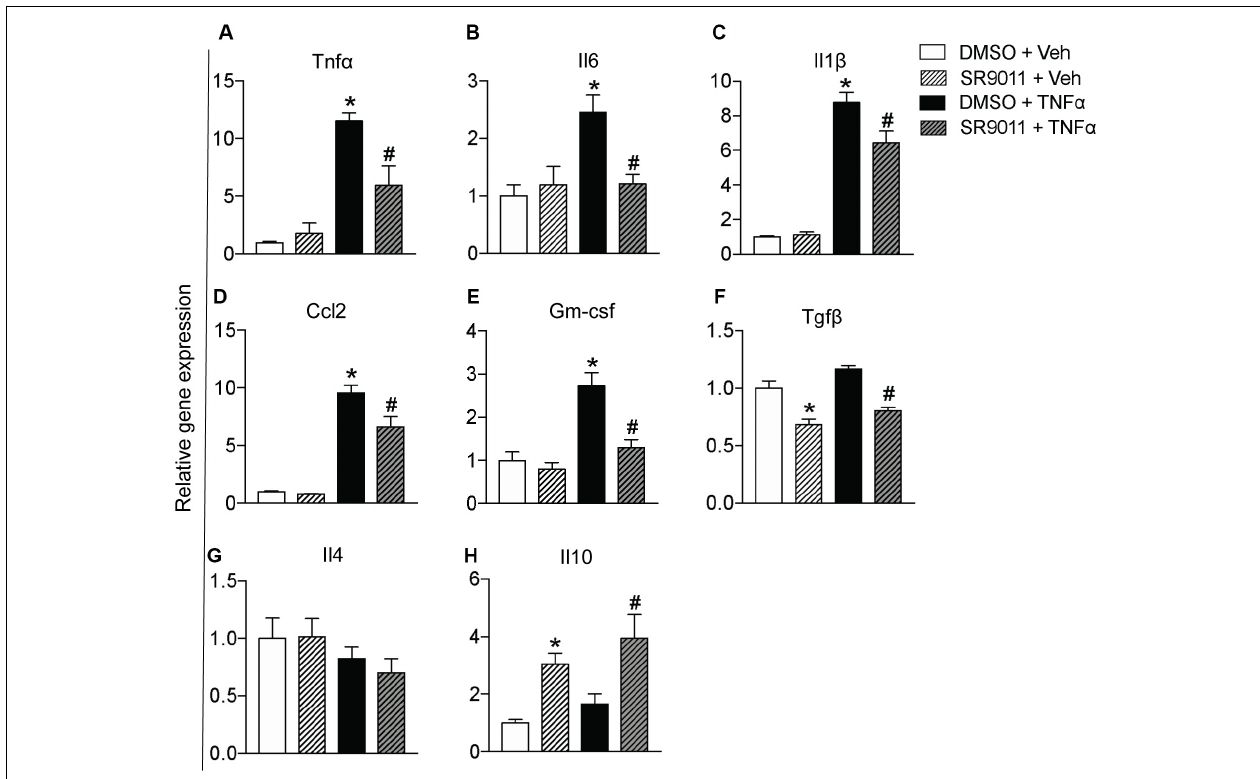
FIGURE 3 | The effect of SR9011 on cytokine expression in microglia. Relative gene expression of cytokines in primary microglia treated with SR9011 or DMSO for 12 h followed by TNF α or BSA treatment for 12 h ( n = 6 per group). This figure shows the effect of TNF α and SR9011 on pro-inflammatory cytokine expression (A–E) , regulatory cytokine expression (F) , and anti-inflammatory cytokine expression (G–H) . TNF α increases the gene expression of Tnf α , Il6, Il1 β , Ccl2, and Gm-csf . SR9011 attenuates the expression of Tnf α , Il6 , Il1 β , Ccl2 , and Gm-csf compared to treatment with TNF α alone. Conversely, SR9011 increases Il10 expression after TNF α stimulation. Data are presented as means ± SEM and statistical significance was determined using Unpaired t -test in all experiments. p < 0.05* vs DMSO + BSA and p < 0.05 # vs DMSO + TNF α .